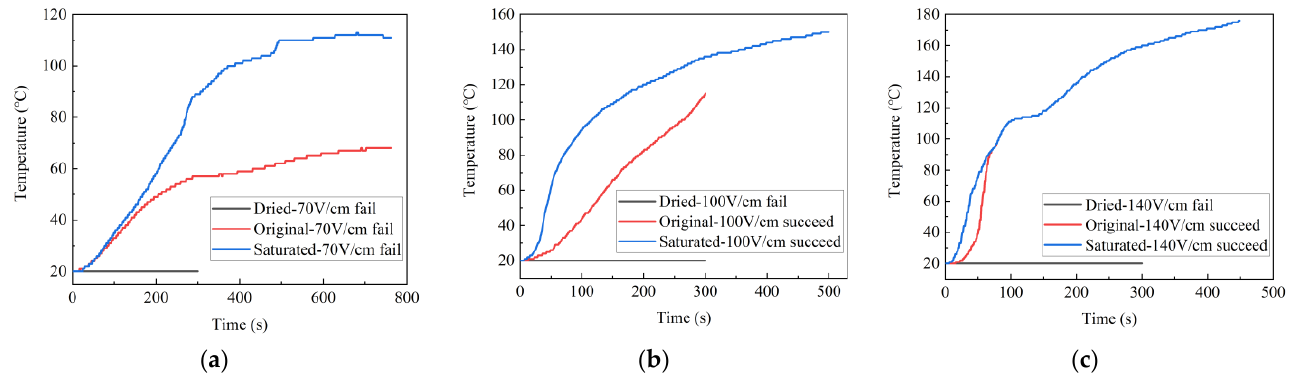
Figure 9. Oil shale temperature changes with time in the different moisture content experiments. ( a ) Electric field intensity of 70 V/cm; ( b ) electric field intensity of 100 V/cm; ( c ) electric field intensity of 140 V/cm.